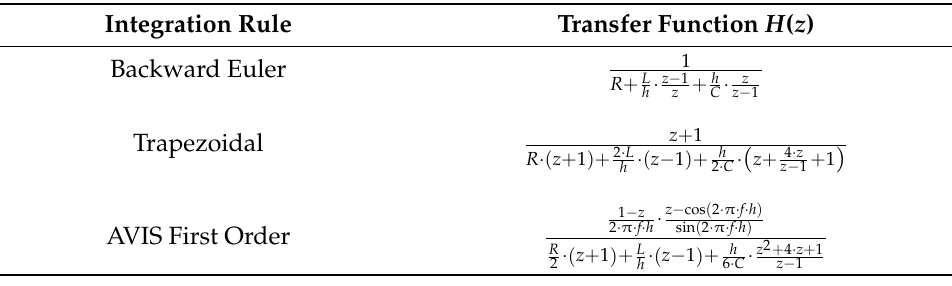
Table 1. Discrete-time transfer function H ( z ) for the integration